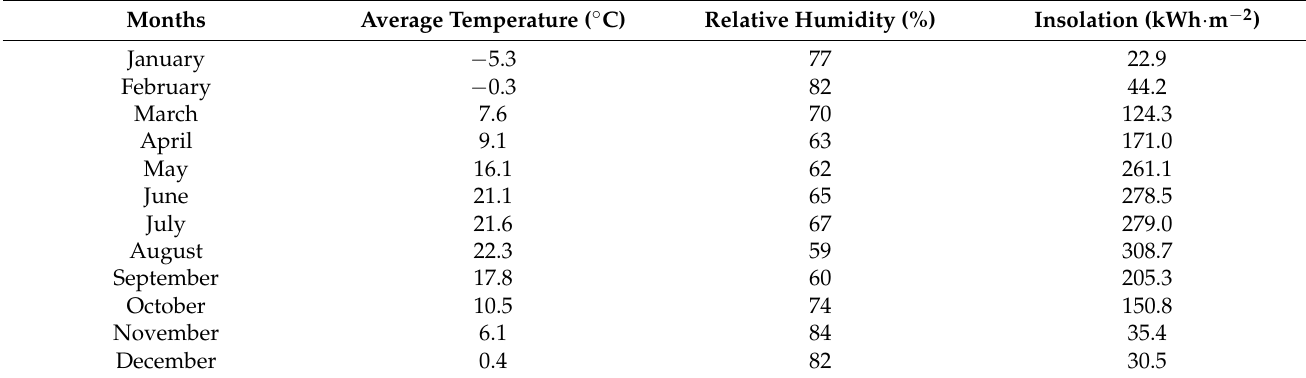
Table 1. Climatic conditions of experimental station, Galati (Romania)—2017.